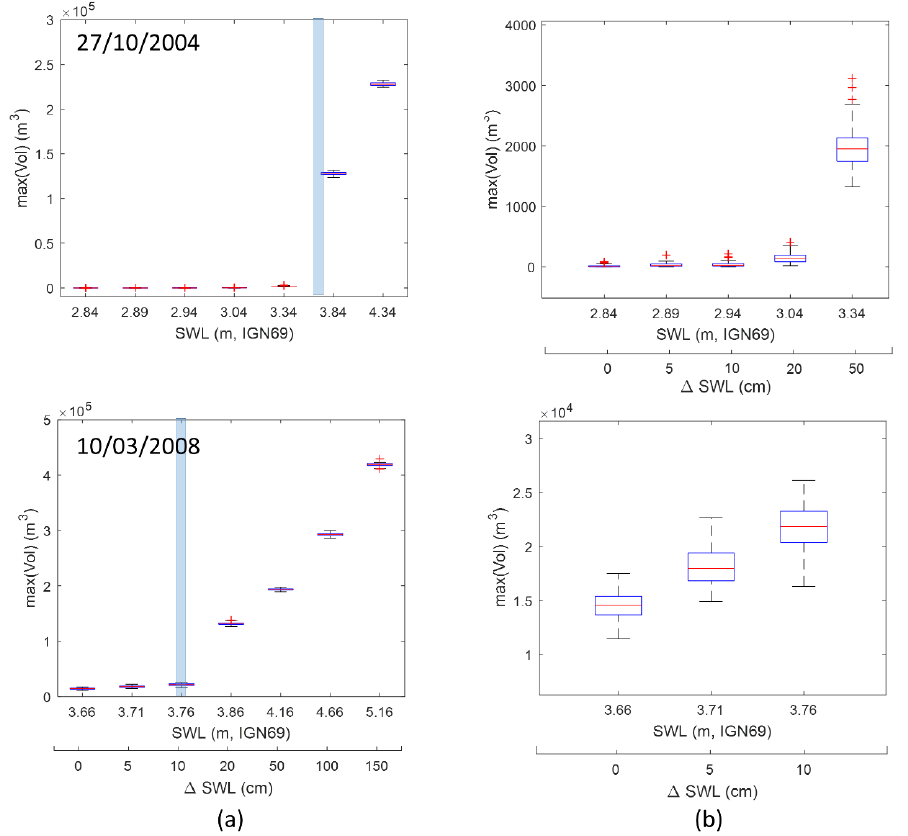
Figure 9. Boxplot of maximum inland water volume (considering 66 simulations for each event) versus the water level (and the still water level increase compared to the reference events) for the 2004 (top panel) and 2008 (bottom panel) events. ( a ) full results (with the blue vertical bar indicating the critical still water level SWL C for overflowing without waves, see Section 3.4), ( b ) zoom on the left part of (a), for SWL < SWL C . To be noted: the SWL and ∆SWL axis have different units (m and cm, respectively).